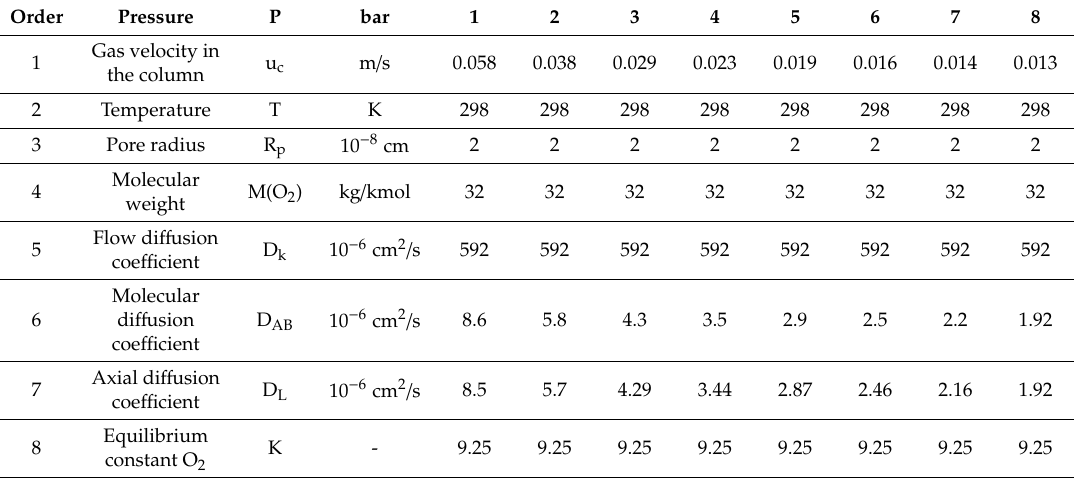
Table 2. Results of calculation parameters of a single fixed bed model at di ff erent pressure.